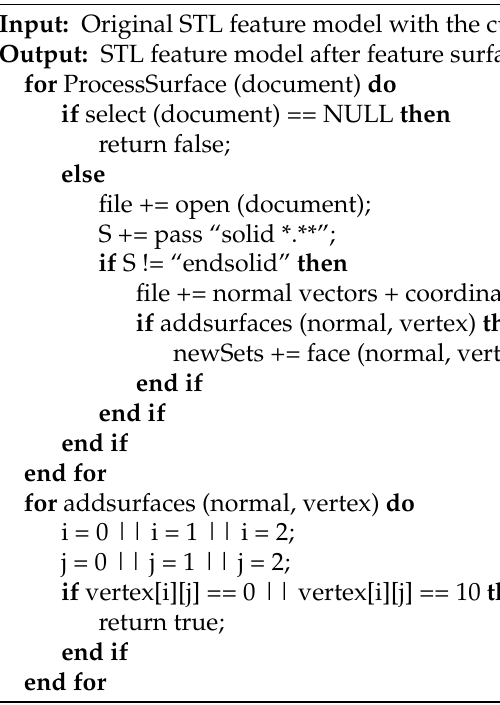
Algorithm 1 The process of machining feature surface set